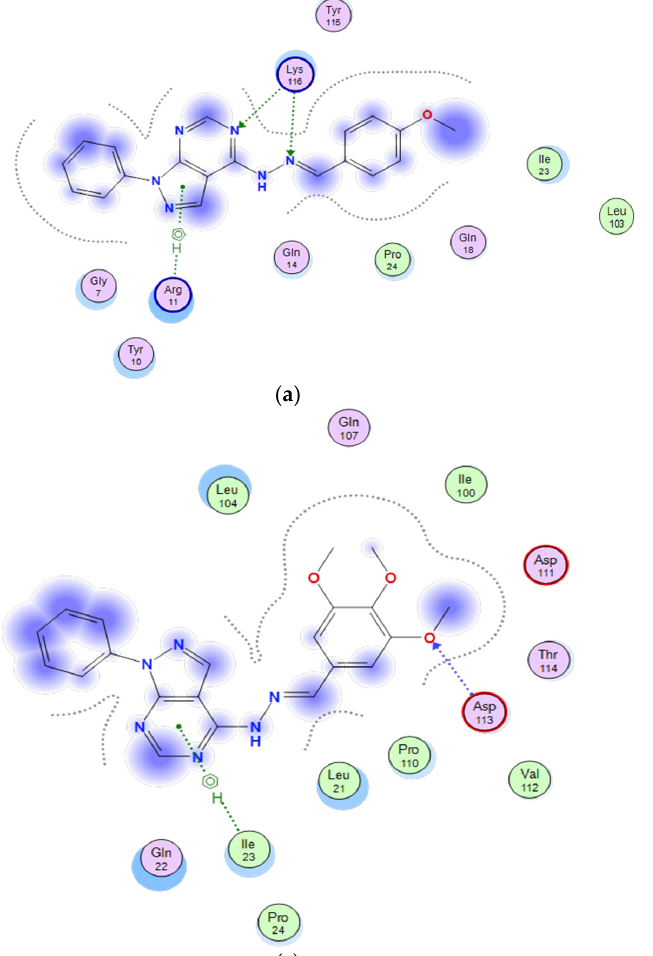
Figure 7. Two-dimensional binding mode of the test compounds ( a ) 6 , ( b ) 5 , and ( c ) 7 in the binding site of Bcl-2 protein (PDB ID: 5whh) using MOE software.